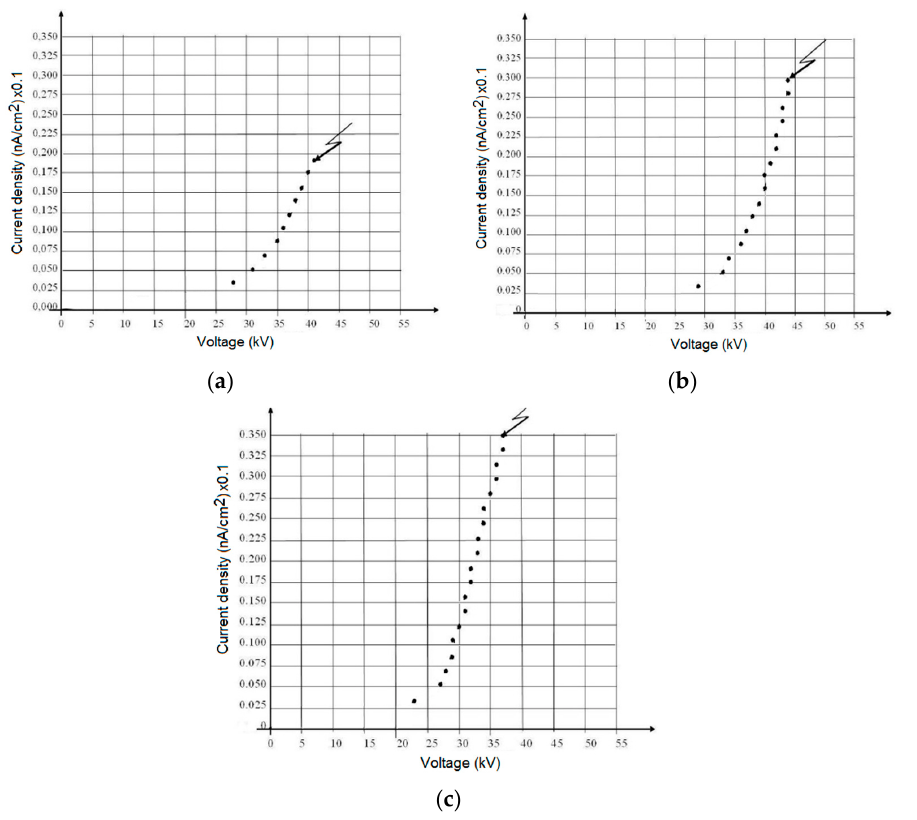
Figure 15. Current density-voltage characteristics for an ESP with three sections: ( a ) section 1 (input); (b) section 2 (intermediate); and (c) section 3 (output).